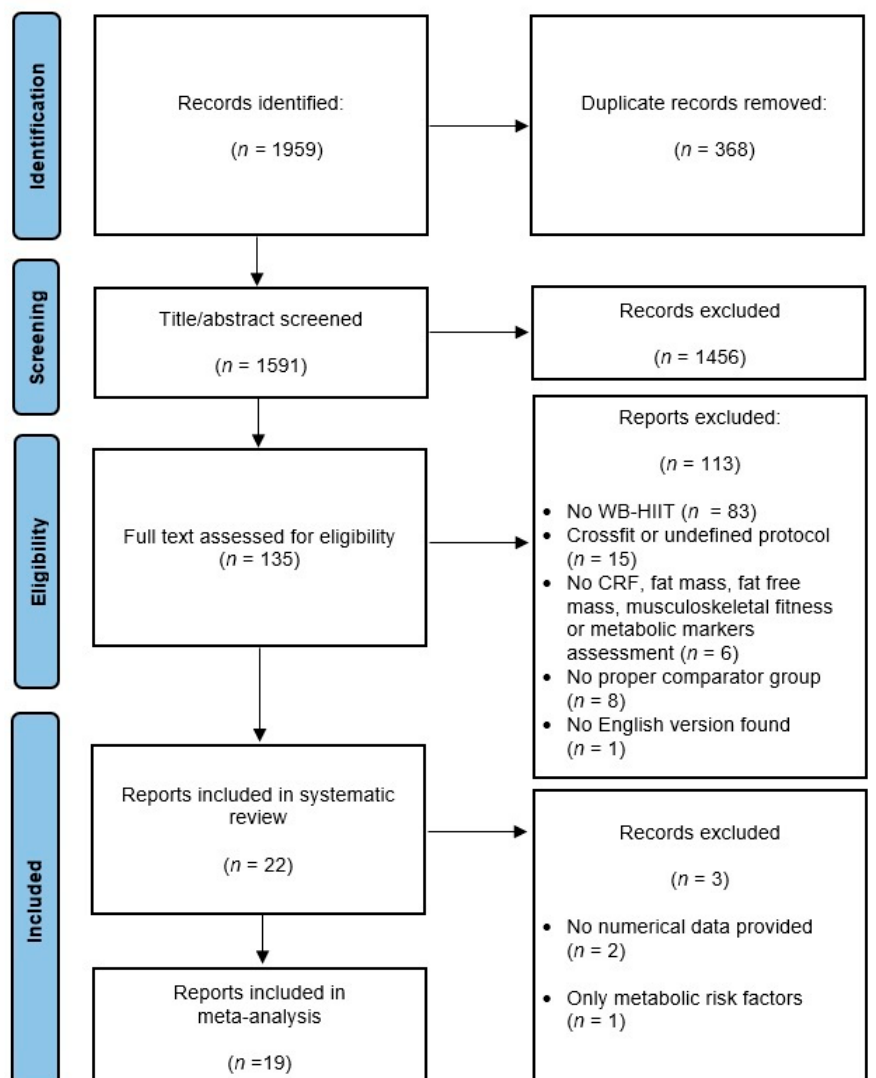
Figure 1. Flow diagram of the identification and screening procedure. WB-HIIT, whole-body high- intensity interval training; CRF, cardiorespiratory